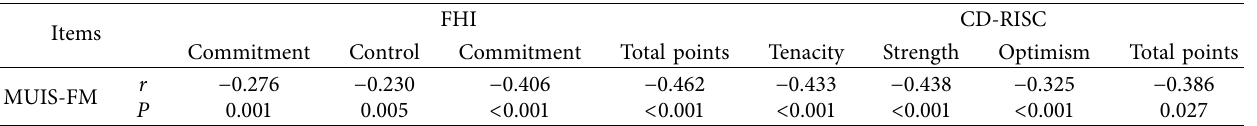
Table 5: Correlation of the guardian’s MUIS-FM score with the FHI score and CD-RISC score.